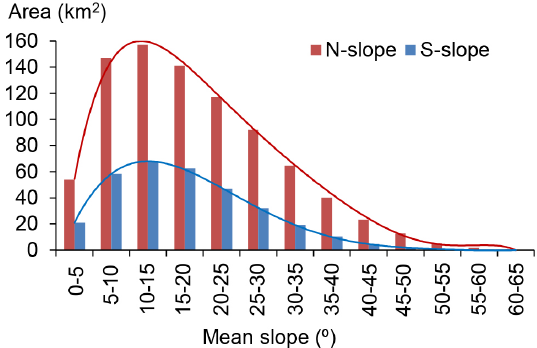
Figure 9. Greater Caucasus, mean slope vs. glacier area for northern and southern